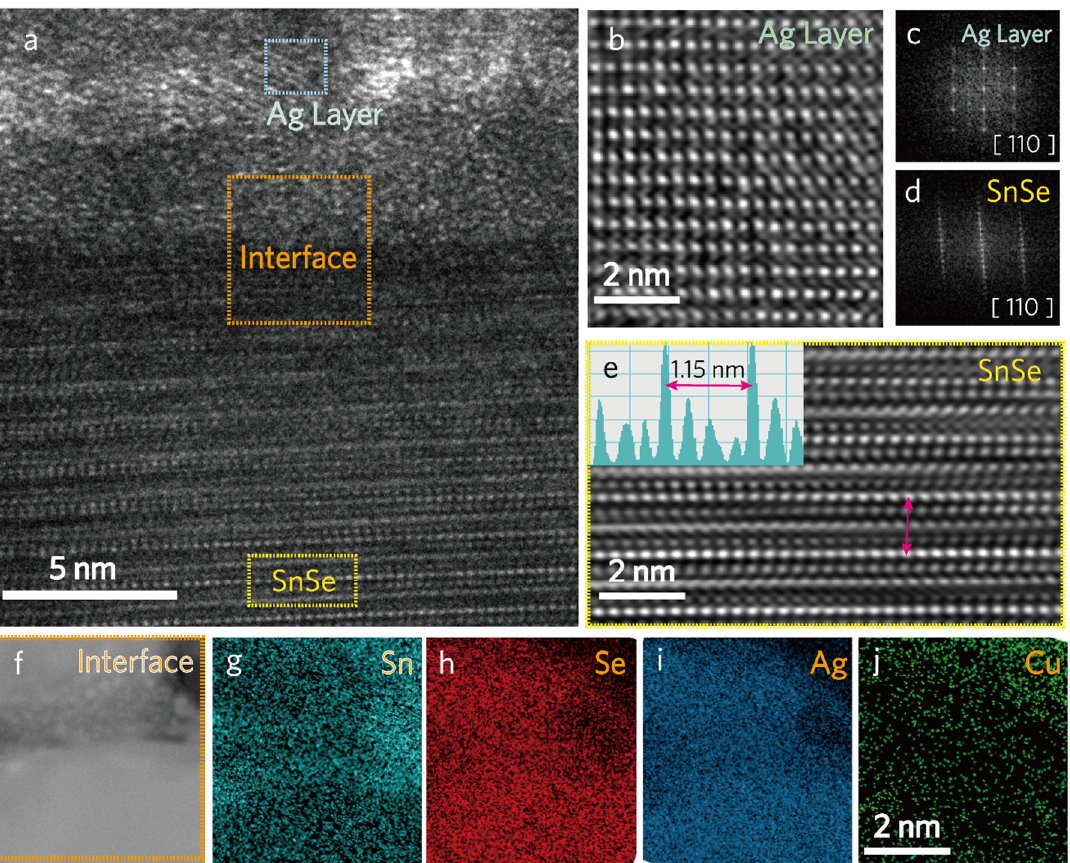
Figure 5. TEM analysis of (Cu 2 Se) 0.005 (SnSe) 0.995 +Ag alloy: ( a ) A cross-sectional BF image, ( b ) IFFT image of magnified Ag layer region ( c , d ) SAED pattern, ( e ) IIFT image of selected area lattice spacing’s, ( f – j ) Elemental mapping taken by EDX-STEM.